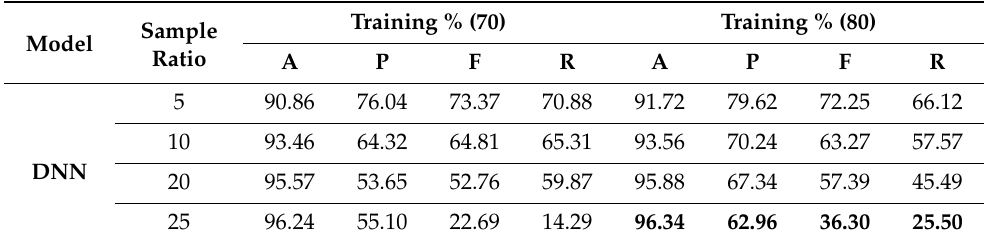
Table 5. Performance evaluation on the benchmark dataset using 1D feature